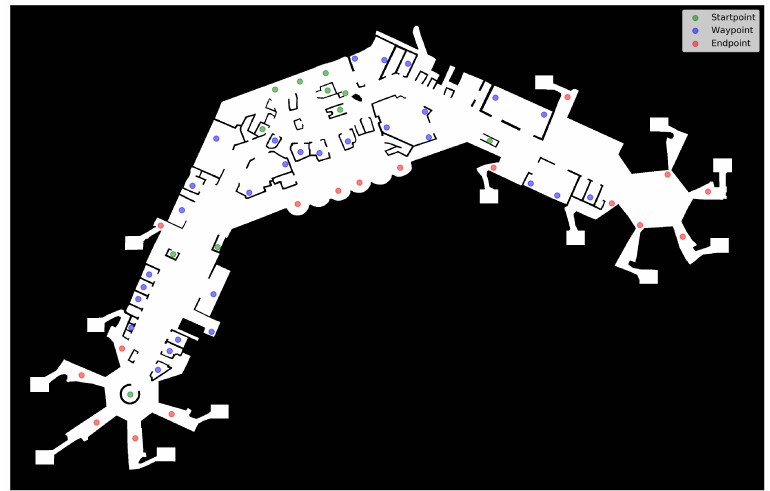
Figure 7. Floorplan with starting- and destination points